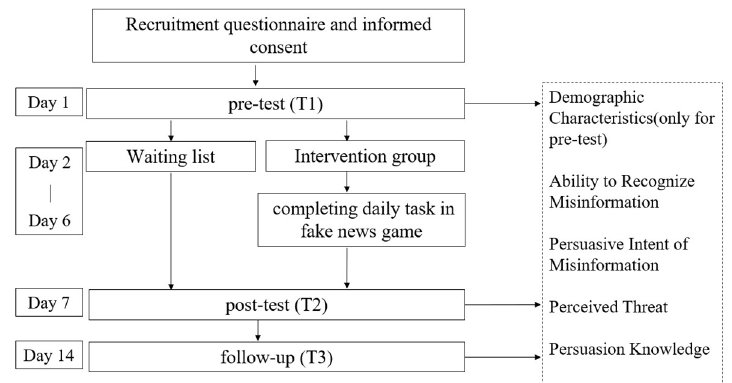
Figure 2. Procedure for Study 2.